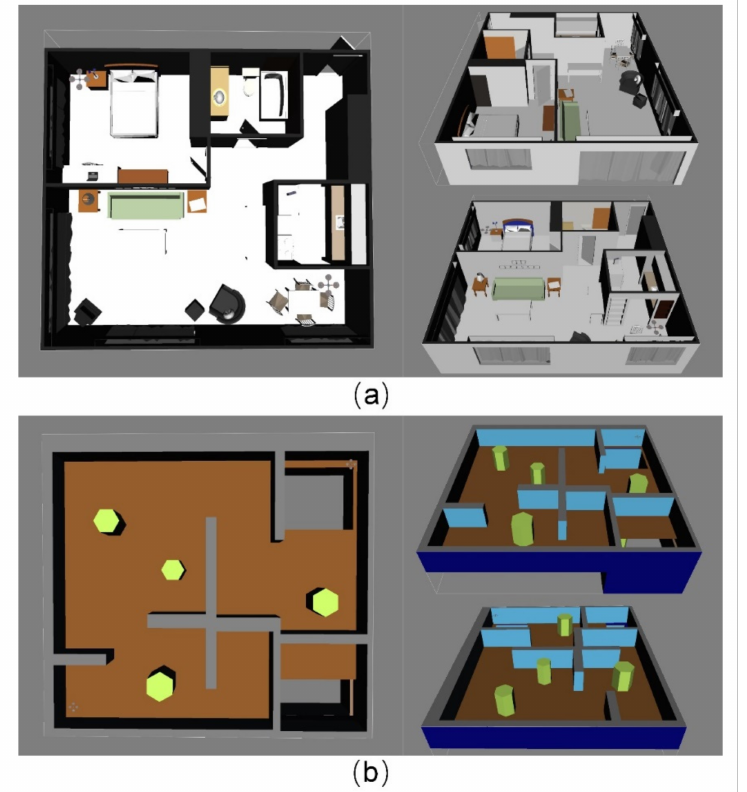
Figure 12. ( a ) Orth views and oblique views of apartment simulation environment, ( b ) Orth views and oblique views of maze simulation